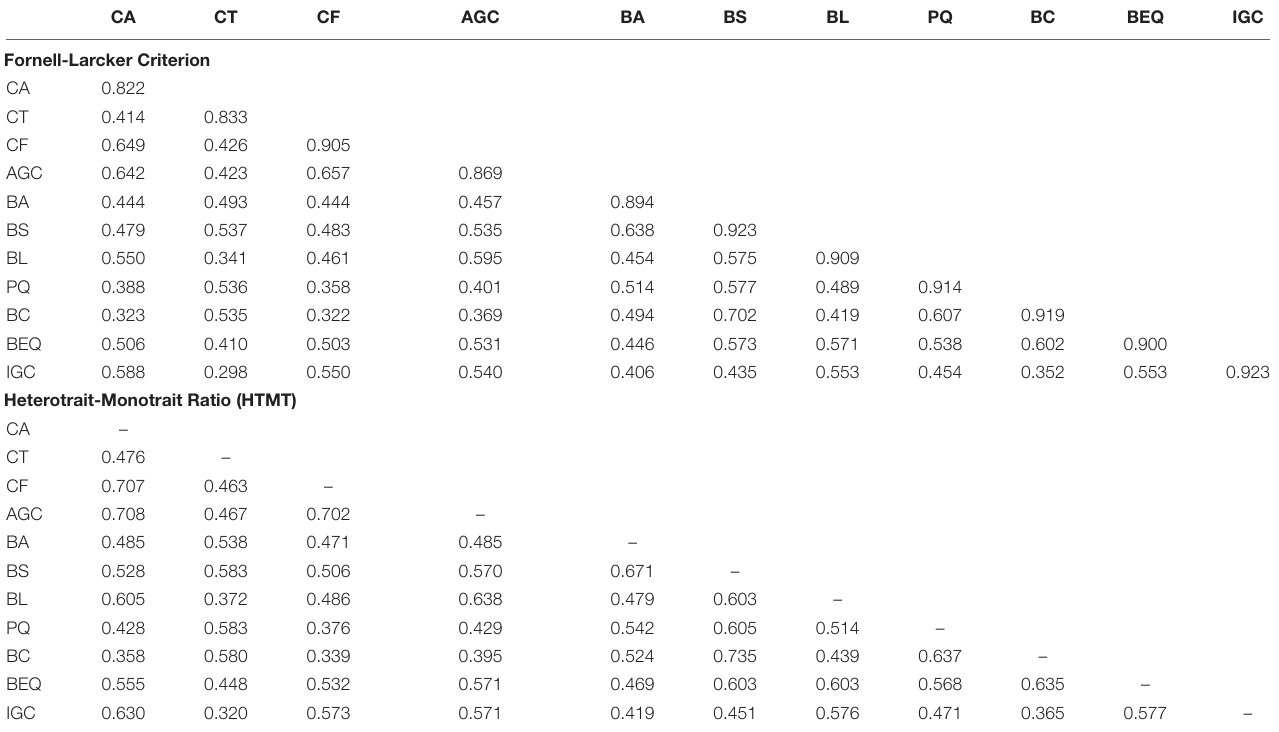
TABLE 4 | Discriminant